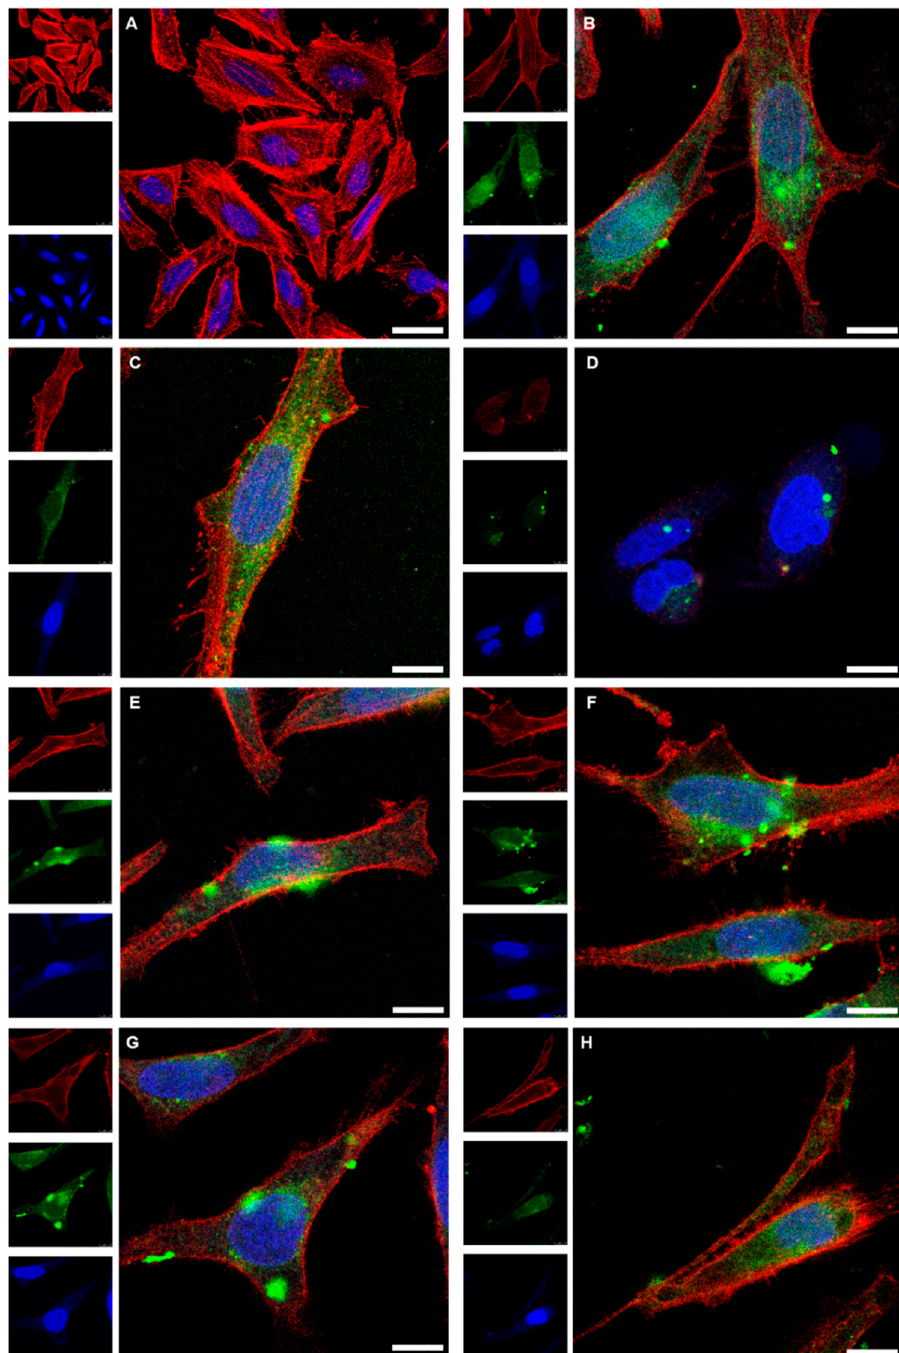
Figure 9. Confocal laser scanning microscopy images of HeLa cells after 24 h cultivation (control; ( A )), and after incubation for 24 h with dispersed Au-GSH-FITC nanoparticles (70 µ g mL − 1 ) ( B ). The uptake of Au-GSH-FITC nanoparticles from coated gelatin capsules after dissolution is shown in ( C ) for Eudragit (88 µ g mL − 1 ), ( D ) for Eudragit-chitosan (65 µ g mL − 1 ), ( E ) for cellulose acetate phthalate (CAP; 60 µ g mL − 1 ), ( F ) for hydroxypropylmethylcellulose-Eudragit